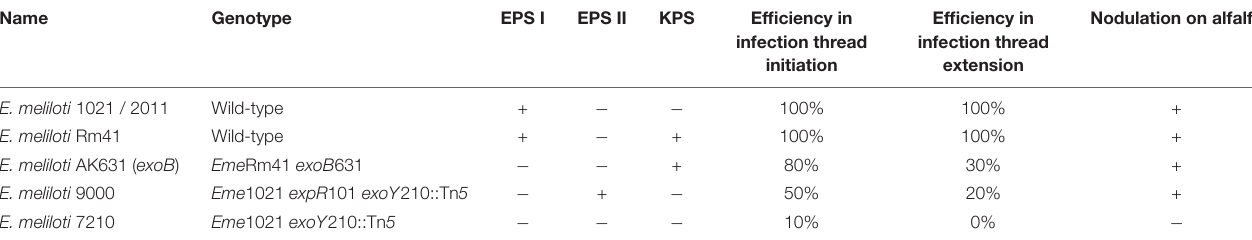
TABLE 1 | Relevant characteristics of different E. meliloti strains with different polysaccharides [Data obtained from Pellock et al.